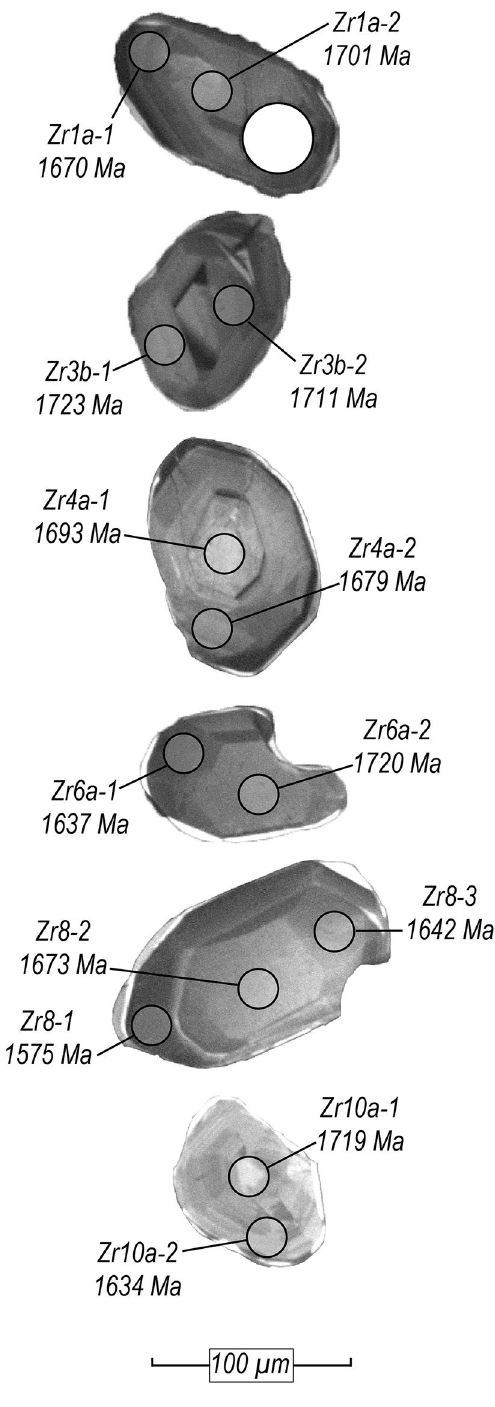
Figure 3. Cathodoluminescence images of representative zircons from sample 90-131A. Grey circles indicate the locations of 19 µm ablation pits. Spot ages are 207 Pb/ 206 Pb ages. The large white circle marks the location of a previous laser-ablation